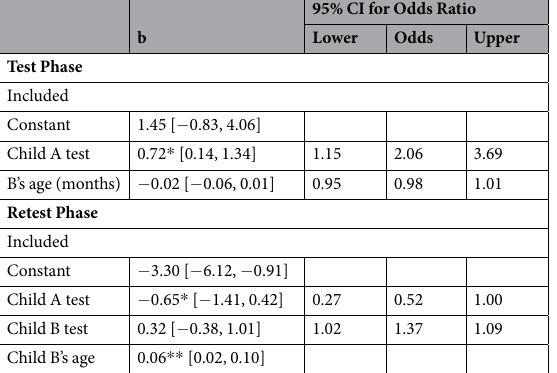
Table 1. Coefficients of the model predicting B’s level of prosocial donating at test and retest in the agent condition [95% BCa bootstrap confidence intervals based on 1000 samples]. Note. Test R² = 0.05 (Cox &